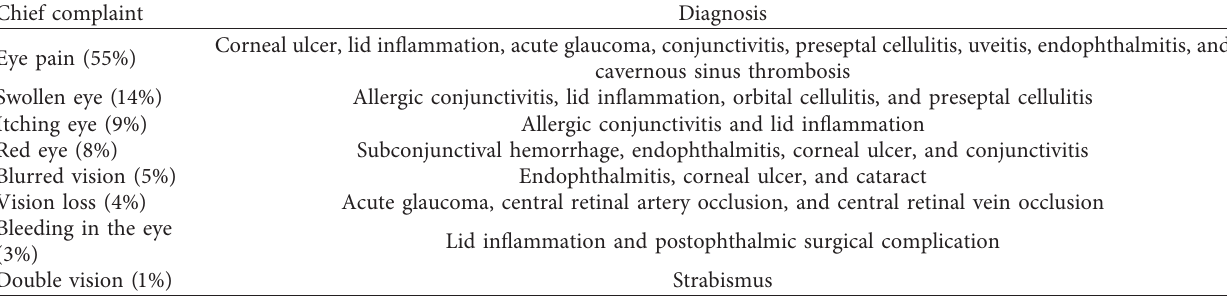
Table 5: Diagnosis of nontraumatic eye disease classified by the chief complaint.